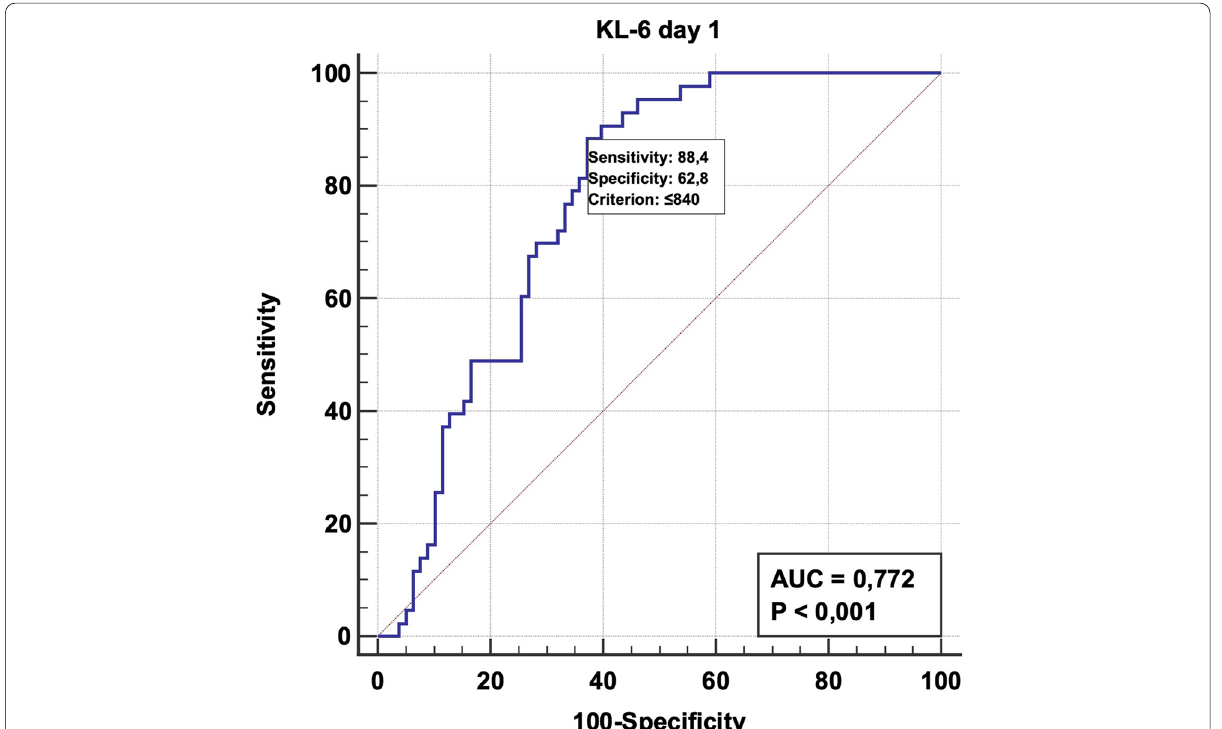
Fig. 2 ROC curve analysis of SOFA score on the day of ICU admission. Patients with a KL-6 value above 840 U/ml may experience worse outcome (sensitivity 88.4% and a specificity of 62.8%)